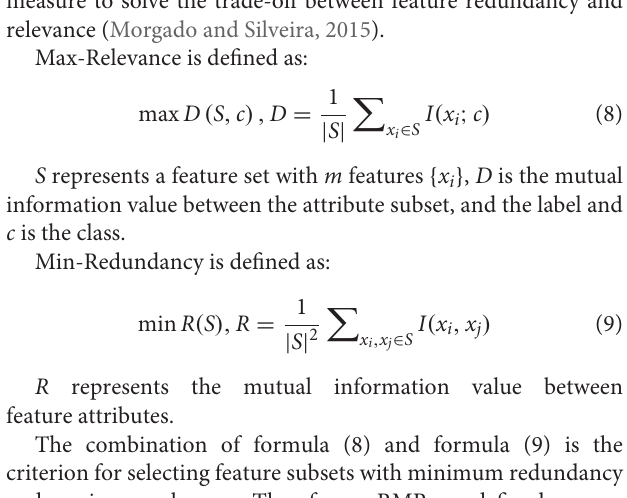
Sparse Linear Regression Feature Selection Algorithm Based on Stationary Selection